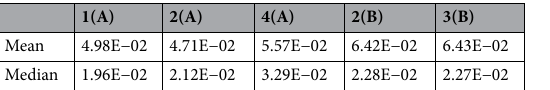
Table 8. Scenario A and B spectral main characteristics at the Petri dishes positions in scenarios A and B.